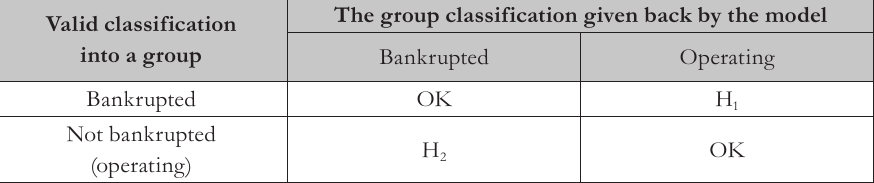
Tab. 2 – How to understand the results. Source: own